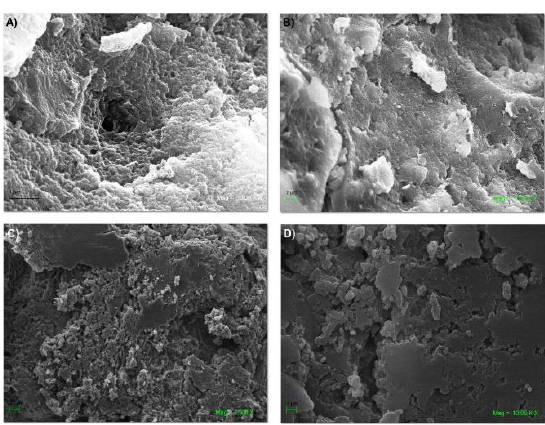
Figure 6. SEM analysis of NSs: ( A , B ) and the NS–DTF inclusion compound ( C , D ).